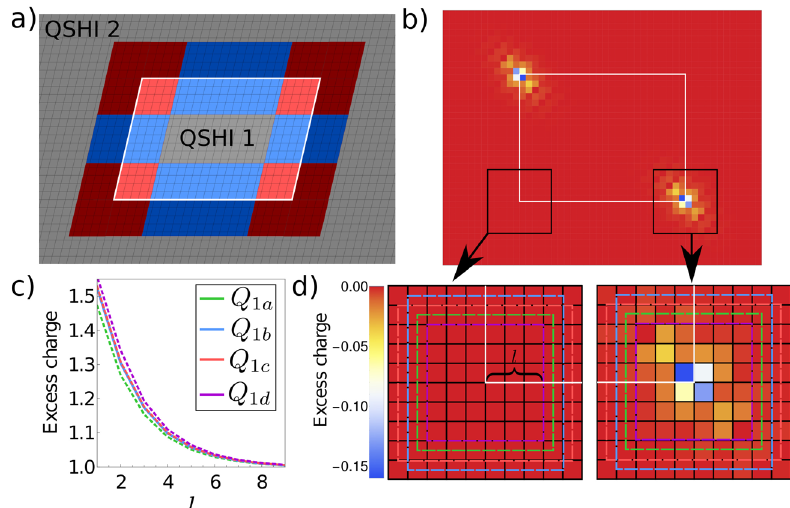
Fig. 4 Quantized corner charges in quantum spin-Hall heterostructures. a ) Schematic of a C 2 QSH system embedded in another QSH system with periodic boundary conditions. The edge and corner regions of the interface are colored blue and red, respectively. b ) Corresponding charge density for the QSH systems discussed in the text. c ) Behavior of the corner charge as a function of the l × l corner regions size. d ) Zoom in of the charge density, depicting the two corners and the regions used to calculate the corner